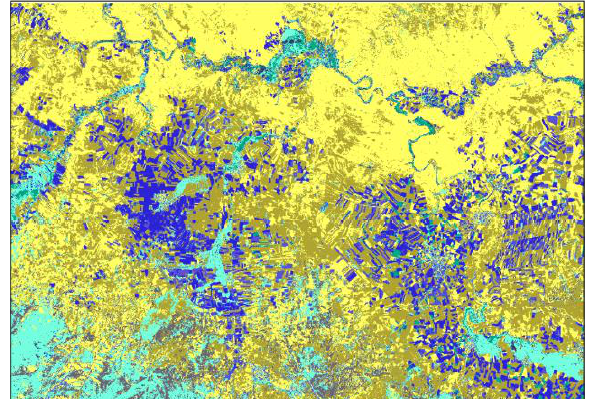
Figure 3. Supervised Classification results